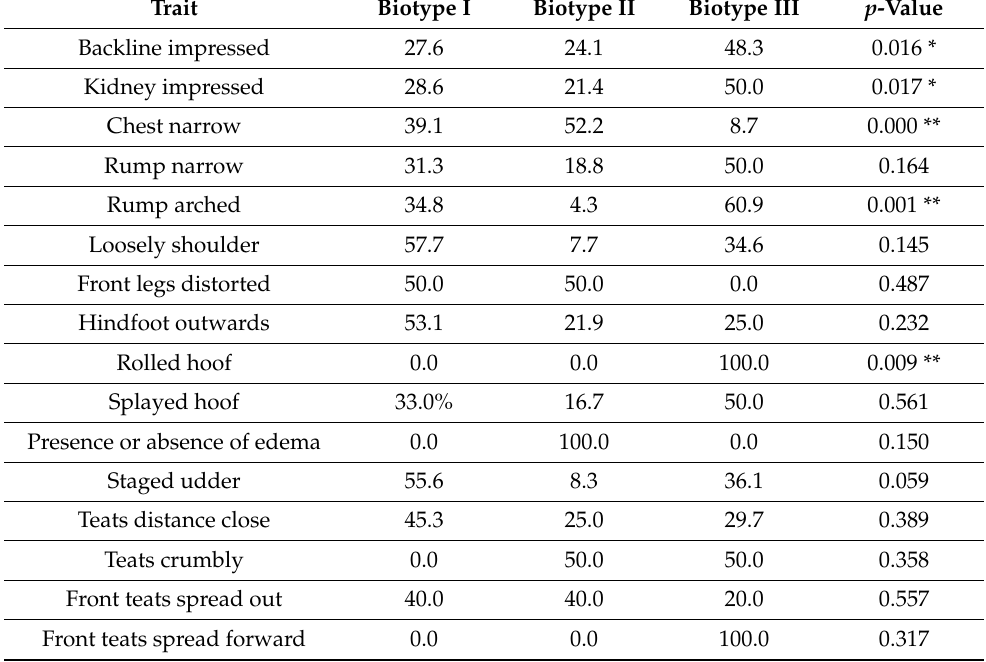
Table 3. Presence of defects in Creole cows biotypes from Amazonas region, Peru (%) 1 .